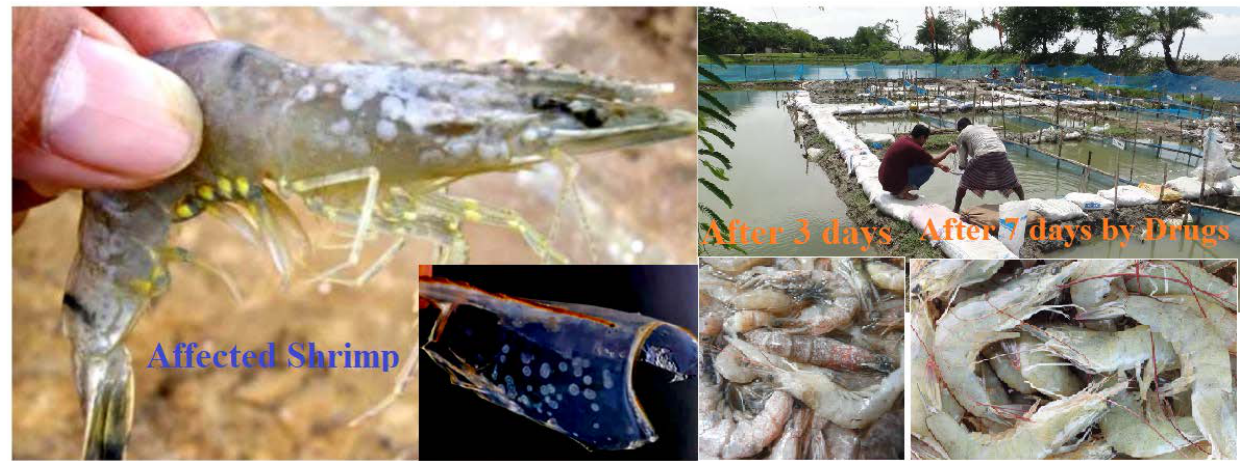
Figure 7. Trial results for the applied doses in WSD of shrimp. Table 9. dose and performance of the drugs.